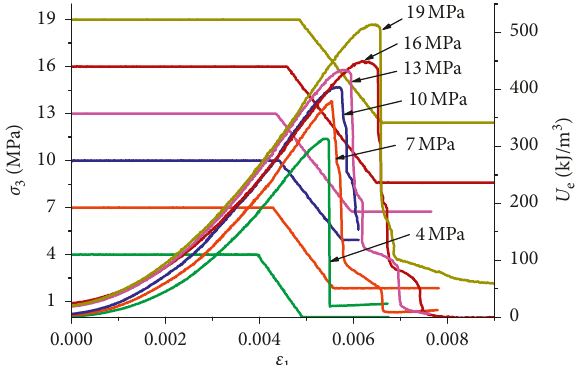
Figure 6: Comparison of elastic energy curves under different confining pressures.